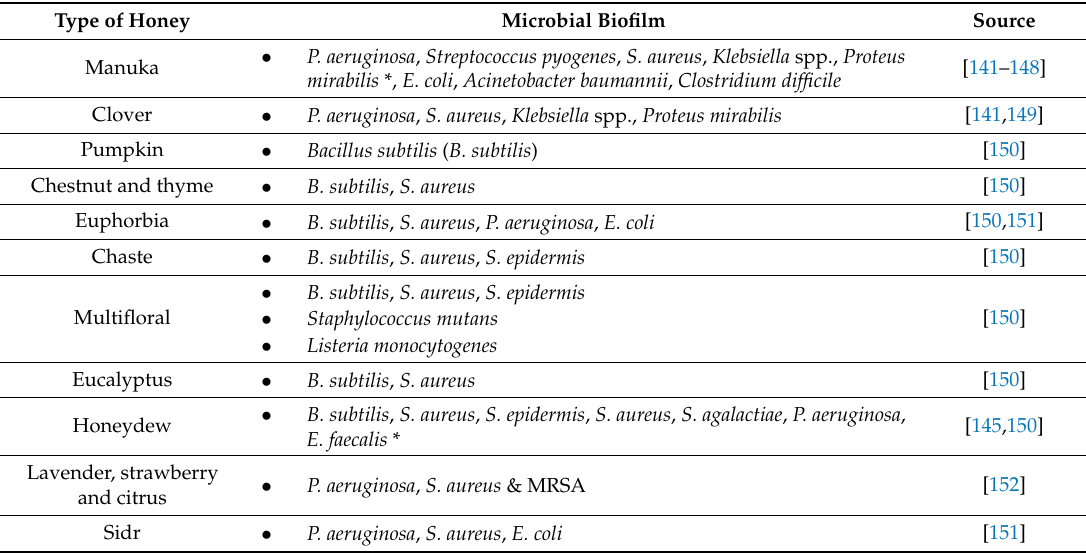
Table 8. Examples of honey with anti-biofilm